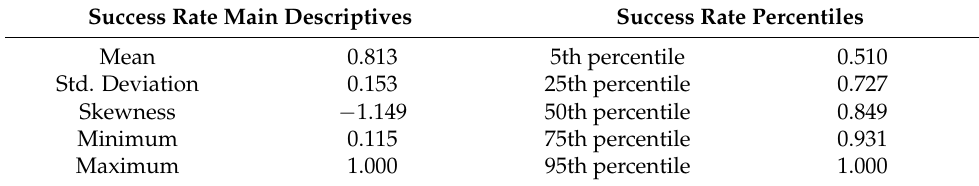
Table 2. The success rate of